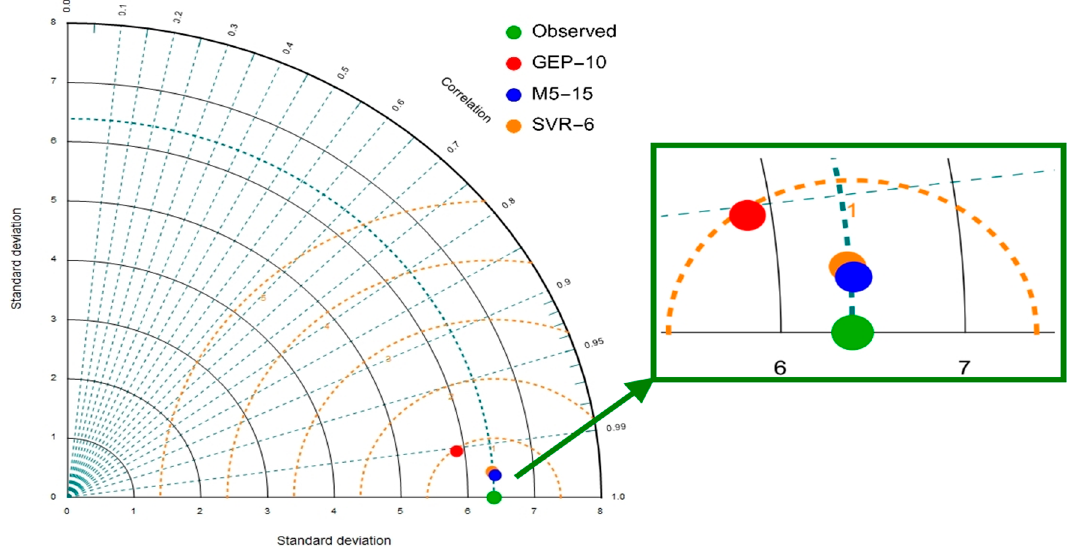
Figure 6. Taylor diagrams of estimated DPT values in the test period.